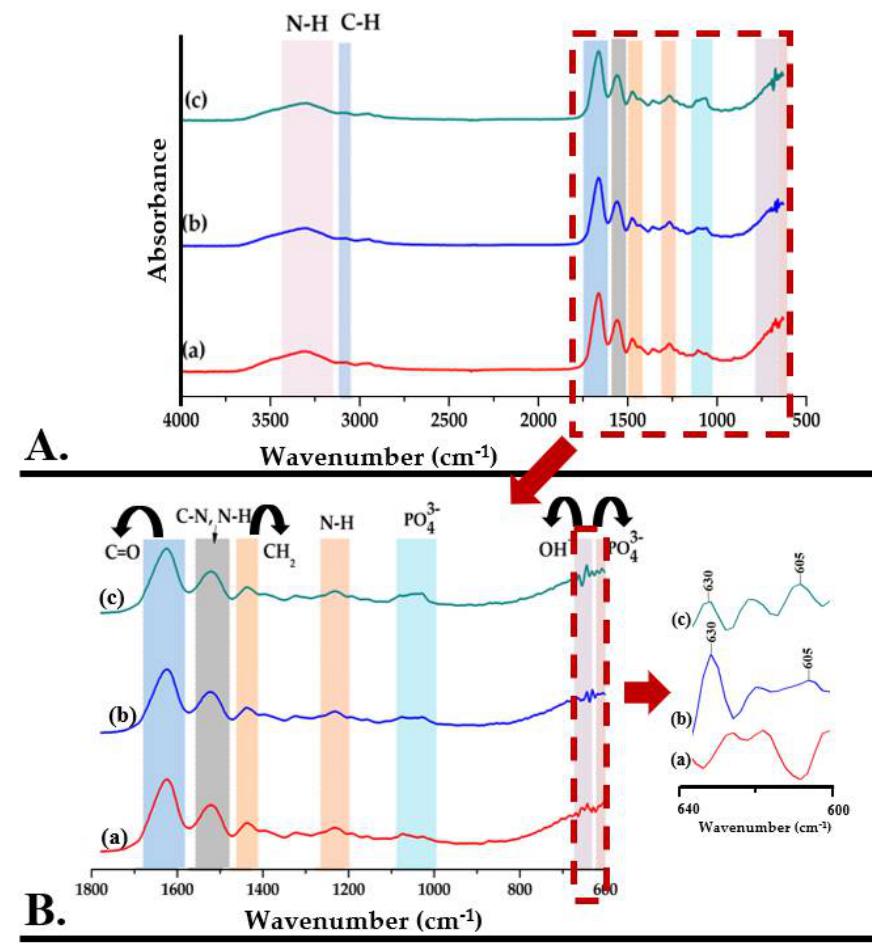
Figure 6. (( A , B )—zoom) FTIR spectra for GelMA (a), GelMA-HMg5 (b), and GelMA-HZn5 (c). The Fourier transform infrared spectrum of composite materials—GelMA-HMg5 and GelMA-HZn5 (Figure 6A(b,c))—shows the overlap of the peaks characteristic for the mineral phase with those of methacrylate gelatin. The wide peak from 3100–3500 cm − 1 and the one from 630 cm − 1 are attributed to the stretching vibrations of the OH - groups. The absorption bands specific to HA are also identified by the presence of peaks from 603, 1033 cm − 1 and 1082 cm − 1 , which are characteristic of the group PO 43 − ( υ 4 ), PO 43 − ( υ 2 ), and PO 43 − ( υ 3 ), respectively